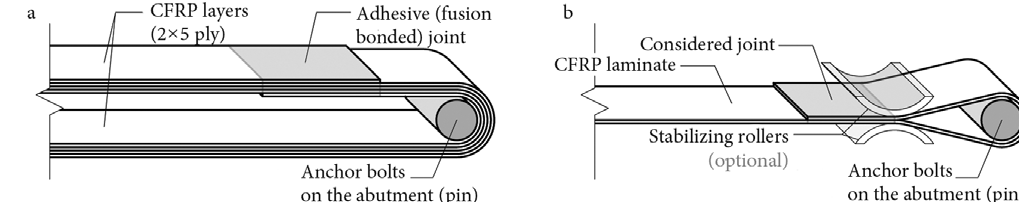
Fig. 3. CFRP stress-ribbon strips: a – non-laminated strip-loop (Empa); b – the considered single-lap joint for the laminated loop